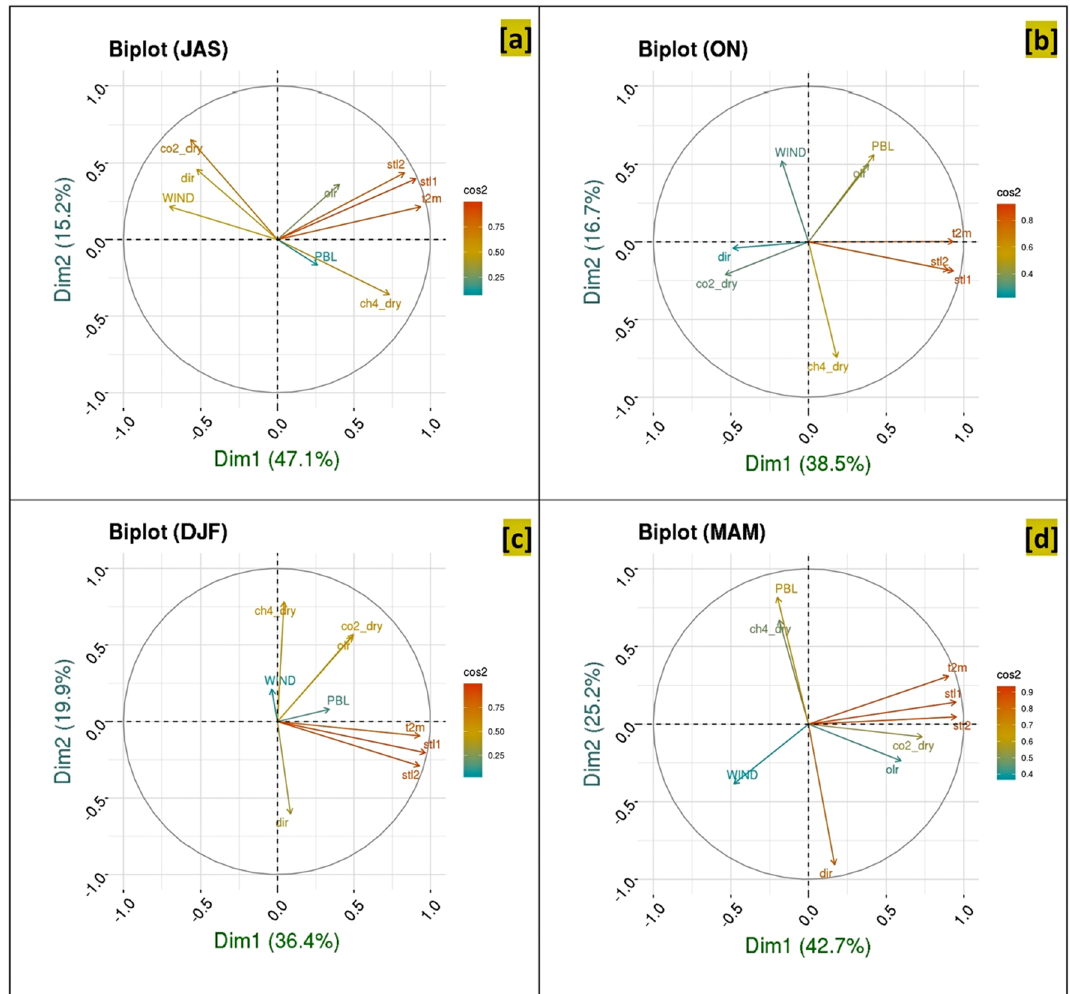
Figure 5. Biplot in PC1 and PC2 space showing the association of individual variables and their phase relationship for ( a ) monsoon (July–August–September), ( b ) post-monsoon (October–November), ( c ) winter (December–January–February), and ( d ) pre-monsoon (March–April–May).